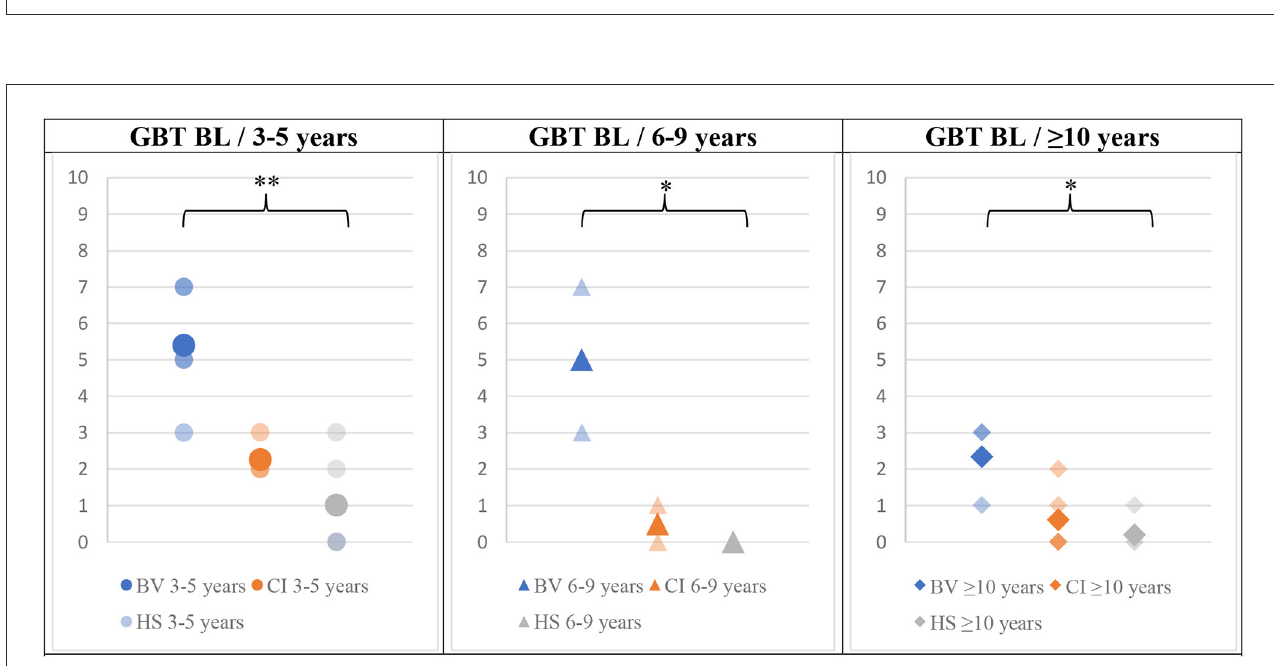
FIGURE3 Means (solid symbols) and individual results (semi-transparent symbols) of the GBT in the BL condition, for the three age sub-groups, from left to the right; 3–5/6–9/ ≥ 10 years old. * p < 0.017/** p < 0.004 (with Bonferroni correction).